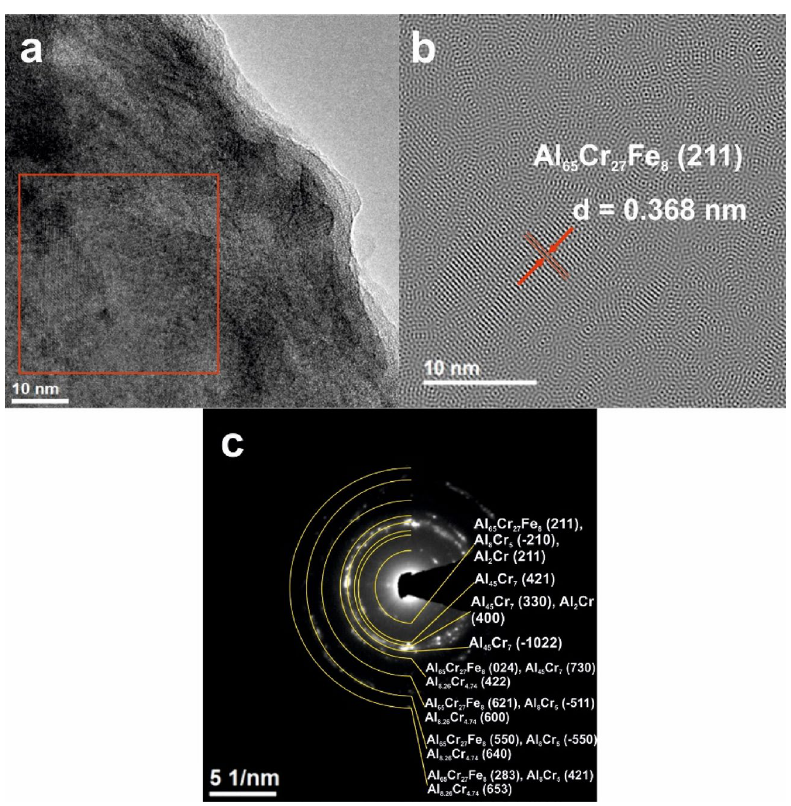
Figure 5. HRTEM image ( a ), IFT image ( b ) and SAED patterns ( c ) of Al 71 Cr 24 Fe 5 plate.